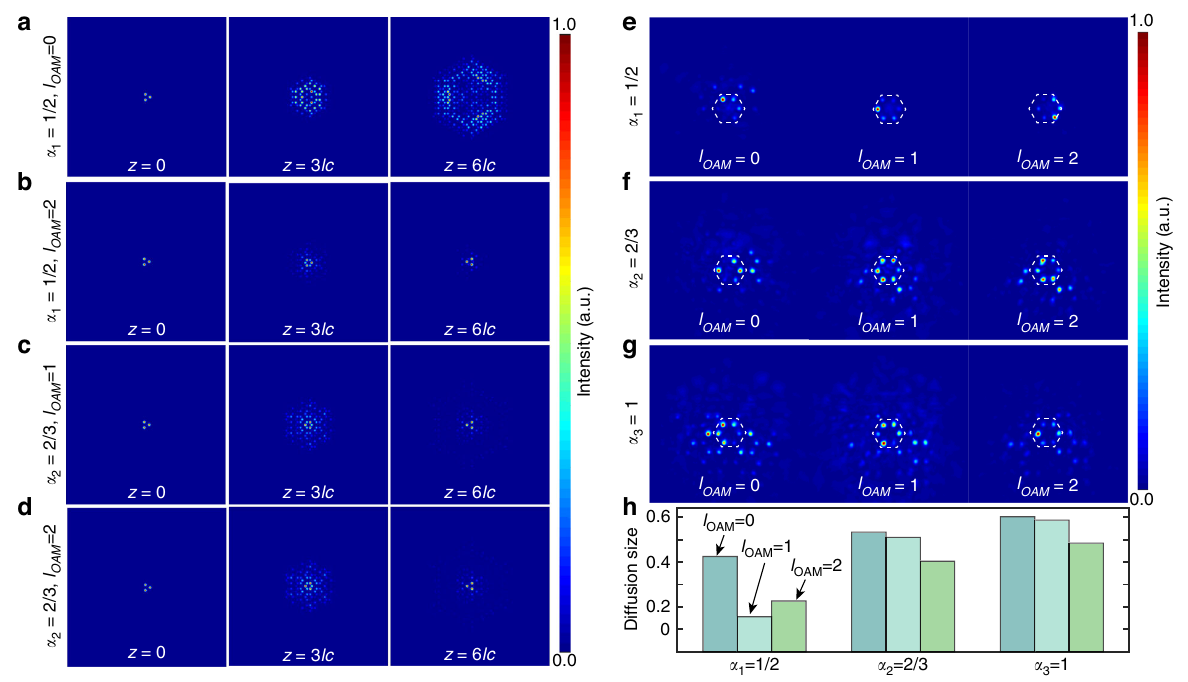
Fig. 4 The ability to distinguish photons whether they had orbital angular momentum or not. a and b are respectively the theoretical calculated results for light without orbital angular momentums and with orbital angular momentum l OAM = 2 in the cosmic string with mass density parameter α 1 = 1/2. c and d are respectively the theoretical calculated results for light with orbital angular momentum l OAM = 1,2 in the cosmic string with mass density parameter α 2 = 2/3. e , f and g are the experiment results of light with and without angular momentums in the cosmic string with different mass density parameter ( α 1 = 1/2, α 2 = 2/3, α 3 = 1). The white dashed hexagon line indicated the innermost ring site. h is the comparison of the diffusion size for light with different angular momentums in the fl at space and in the cosmic